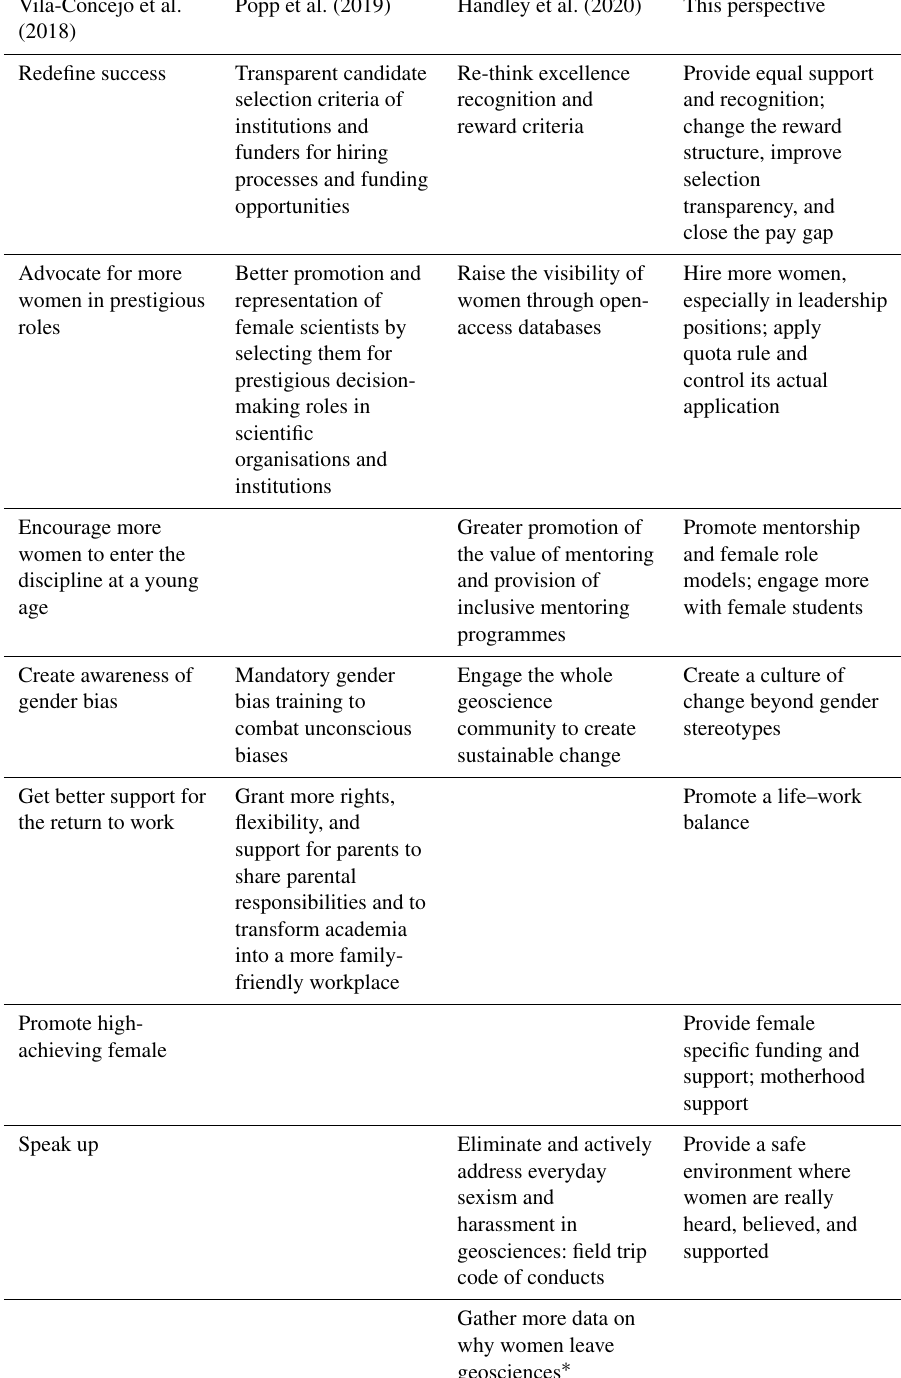
Table 2. Summary of strategies and envisioned solutions towards gender equity in STEM and geoscience from recent literature and this study. It can be observed how the proposed solutions align well among themselves, showing strong similarity. When a solution has been proposed that does not find direct comparison, the related box is left blank. ∗ Handley et al. (2020) focus mainly on the Australasian situation. However, these data are also fundamental for elsewhere in the